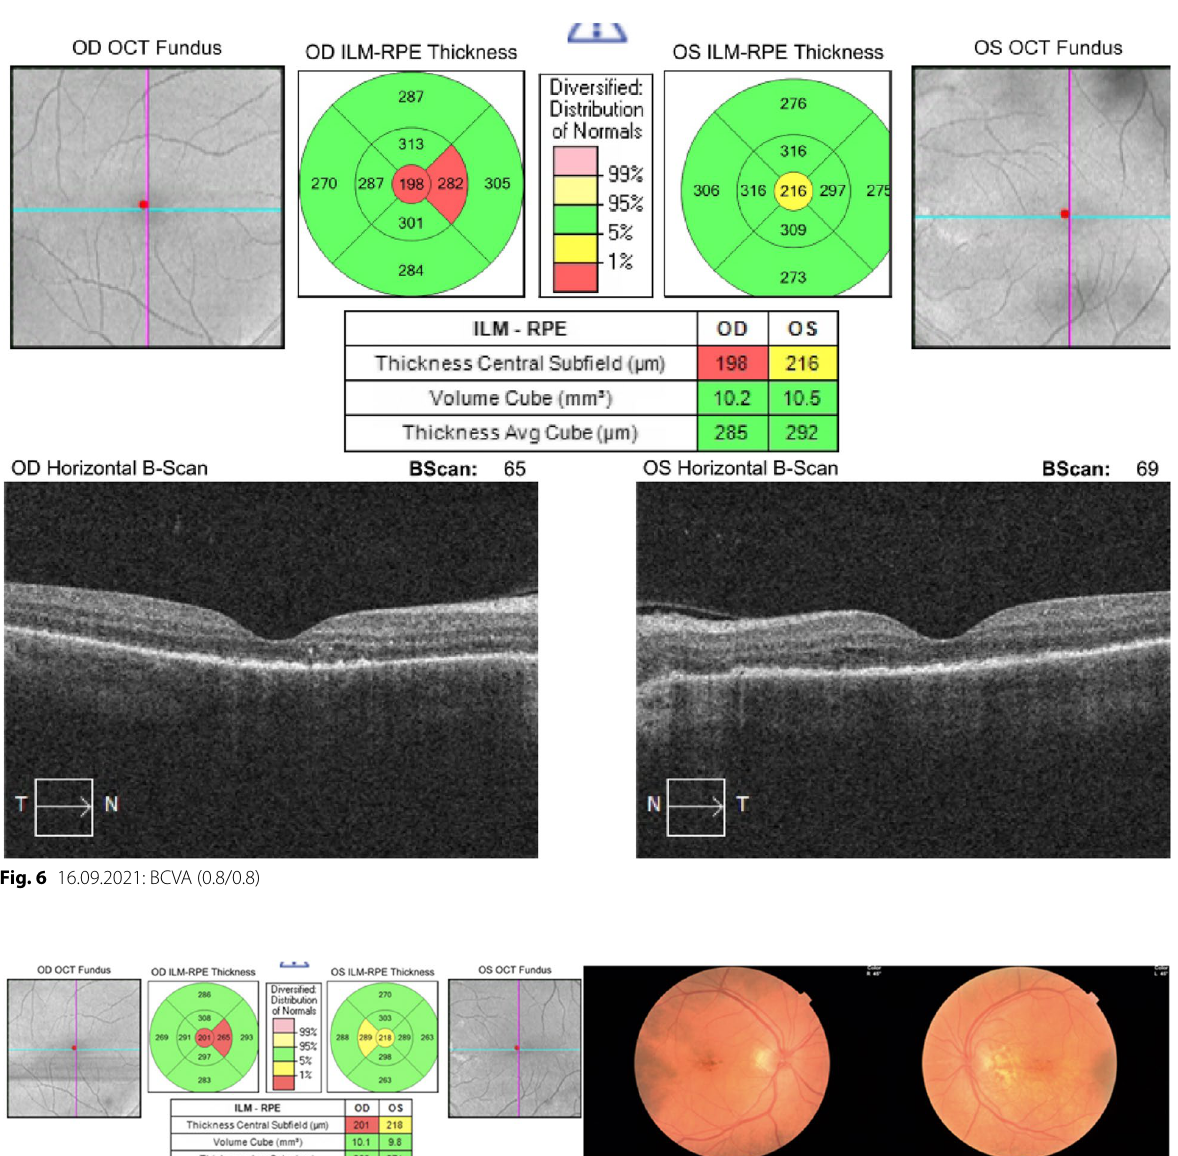
Fig. 7 30.09.2021: BCVA